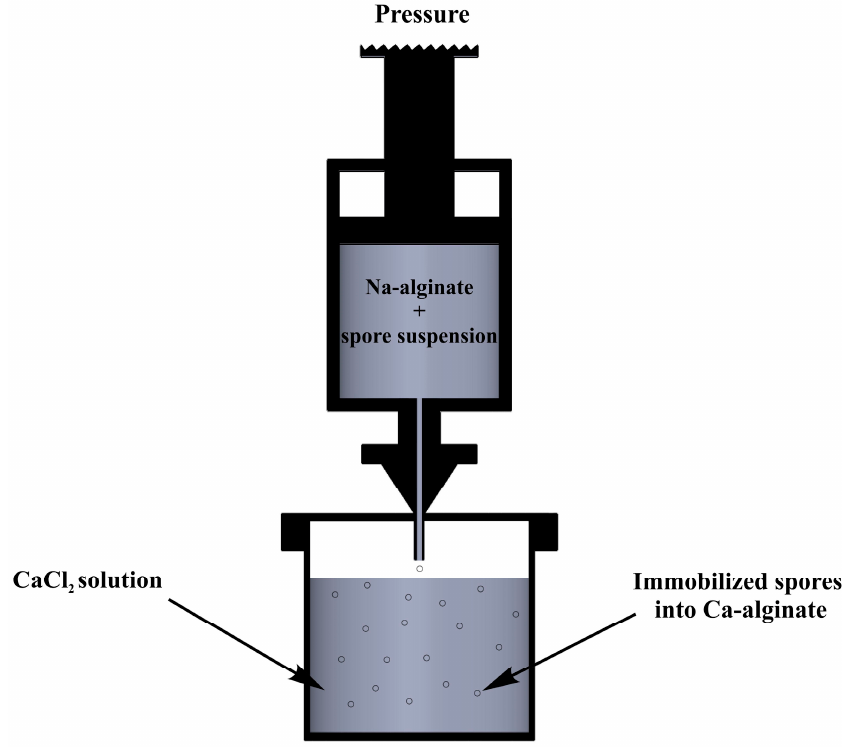
Figure 1. Experimental set up for production of immobilized bacterial cells into Ca-alginate.